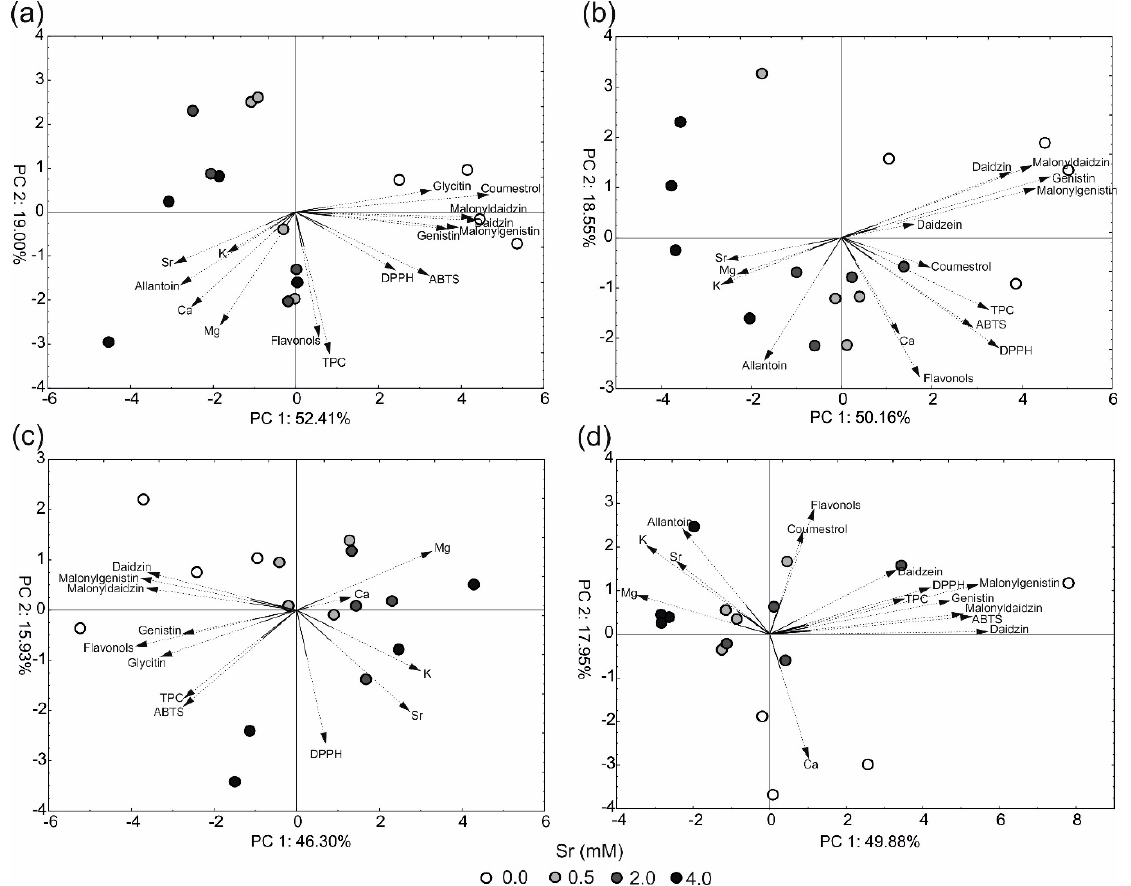
Figure 4. Scatter plot of principal component analysis of selected secondary metabolites, antioxidant capacity, and elements in the soybean organs; ( a ) leaves; ( b ) stems; ( c ) seeds; and ( d ) roots. The length of the dark lines shows a correlation between original data and principal component axes.